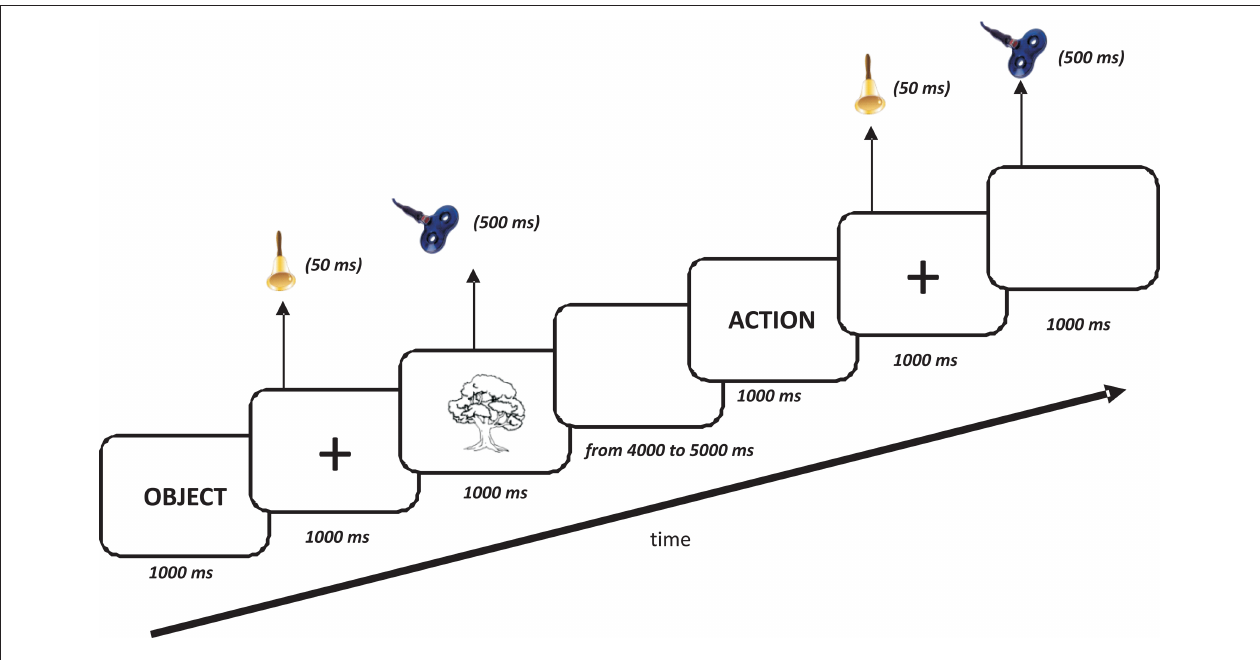
present on the monitor for 1000 ms while trains of rTMS (500 ms, 20 Hz, 10% subthreshold) were delivered simultaneously with the picture presentation. Verbal reaction times were recorded with a